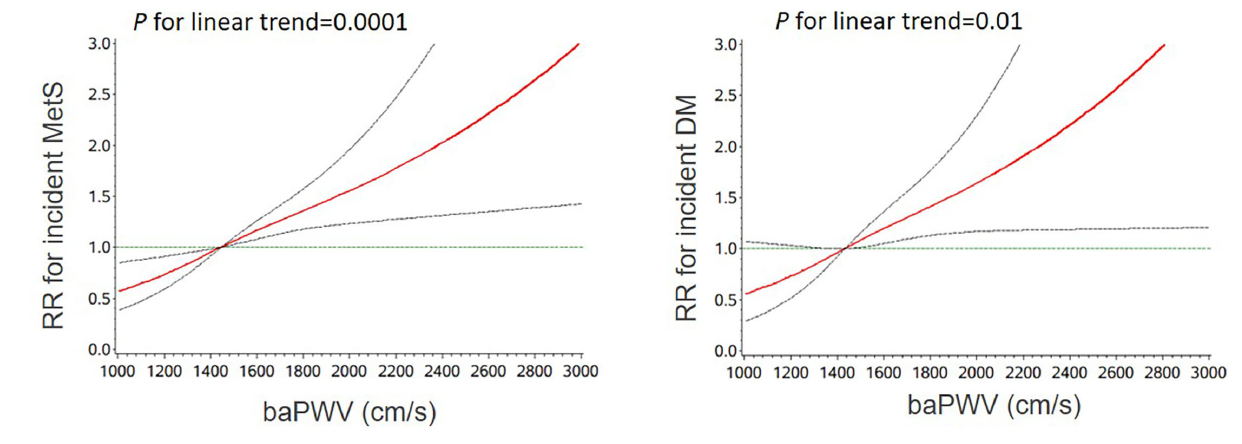
FIGURE 1 | Multivariable-adjusted RRs (95% CIs) for the association of incident metabolic syndrome and diabetes with baPWV. Adjusted for age, sex, current smoking (yes/no), current drinking (yes/no), education, physical activity, SBP, BMI, LDL-C, and FPG. RR, risk ratio; CI, confidence interval; baPWV, brachial–ankle pulse wave velocity; SBP, systolic blood pressure; BMI, body mass index; LDL-C, low-density lipoprotein cholesterol; FPG, fasting plasma